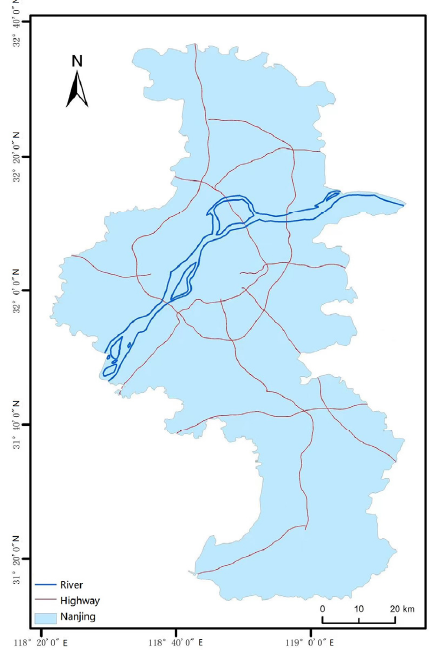
Figure 3. Highway and river buffer zone in Nanjing.